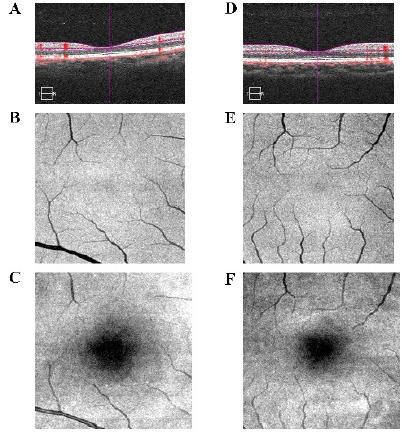
Figure 1. Typical sarcoid manifestations in healthy subjects ( A ) and patients (PAT) ( C ). The ducts of the meibomian gland of the healthy subject are patent as seen by corneal confocal microscopy ( B ), whereas the ducts of the meibomian gland of the PAT appear significantly obstructed ( D ).